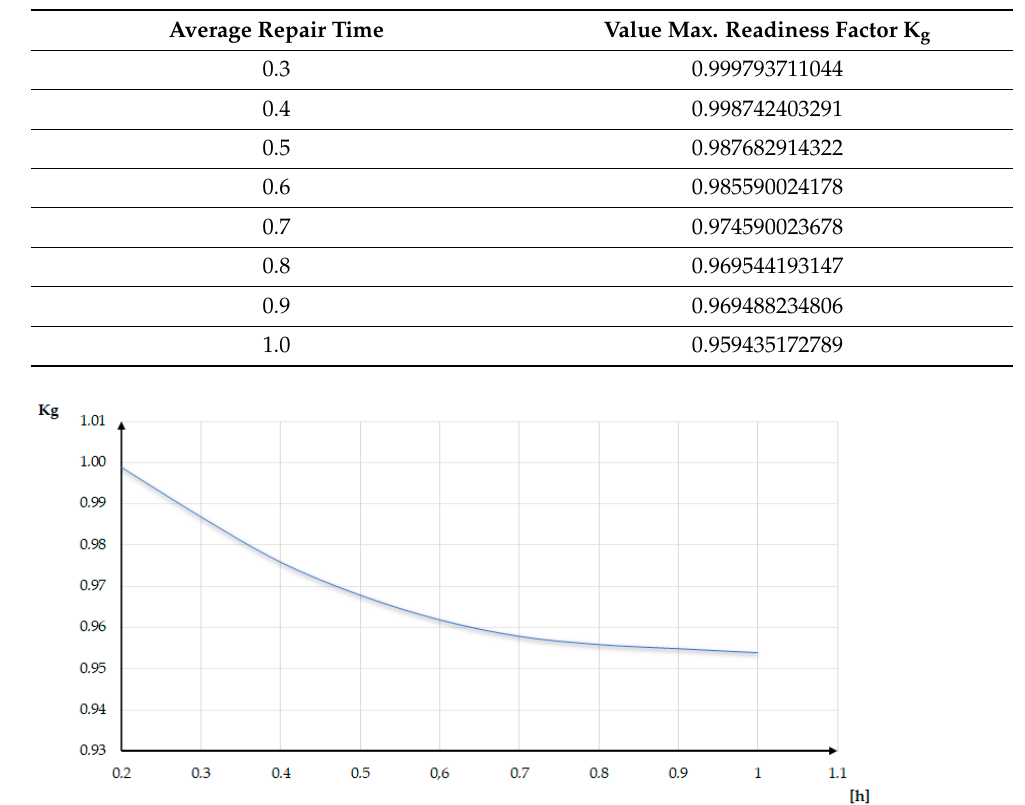
Figure 7. Graphs of the K g availability coefficient in the process of testing the reliability of wind farm devices by changing the value of the average repair time for constant parameters, including: type I mean service time = 0.8 [h]; type II mean operating time = 1.3 [h]; mean time between successive failures = 1200 [h], where: ( a ) mean repair time 0.9 [h]; ( b ) average repair time 1.0 [h]. Table 1. Max. value readiness factor K g .